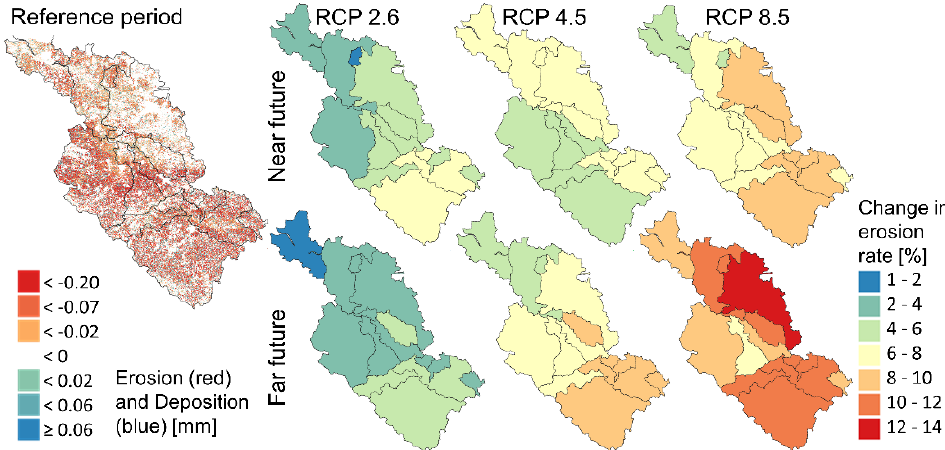
Figure 7. Projected changes in erosion rates for the near future (2031 – 2060) and the far future (2071 – 2100) with respect to the reference period (1971 – 2000). The map shows the 50th percentile of the 23 Pareto optimal simulations run with rainfall erosivity derived from the 50th percentile of average annual precipitation obtained from the DWD reference ensemble of climate simulations.